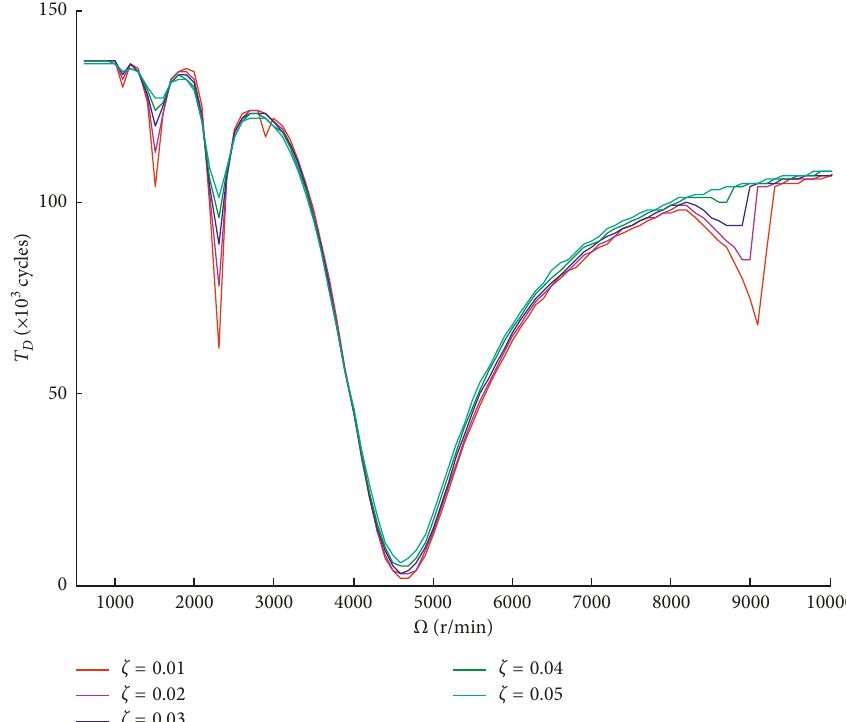
Figure 18: Fatigue degradation life versus rotation speed for various damping with ε � 1 × 10 − 5 m and β � 1/2